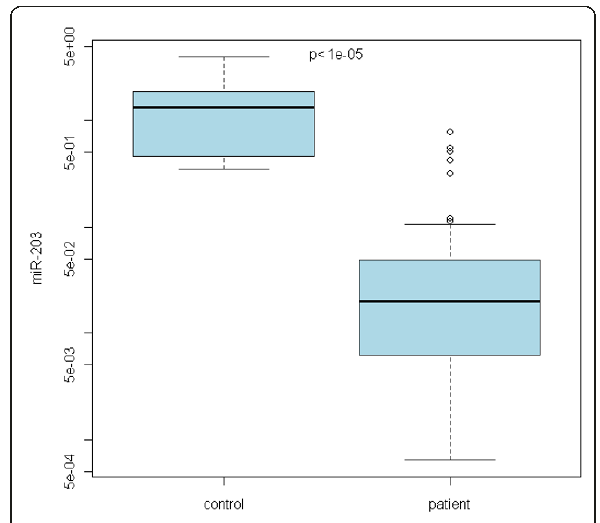
Figure 4 Statistically significant downregulation of miR-203 in BE patients correlated to normal healthy esophageal tissue .